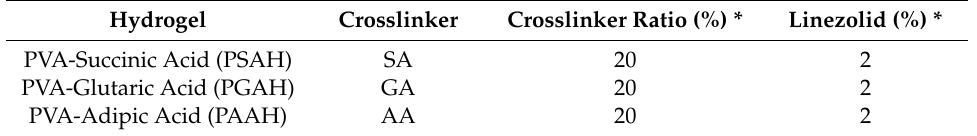
Table 1. Specifications of prepared hydrogels and the amount of linezolid loading. Hydrogel Crosslinker Crosslinker Ratio (%)